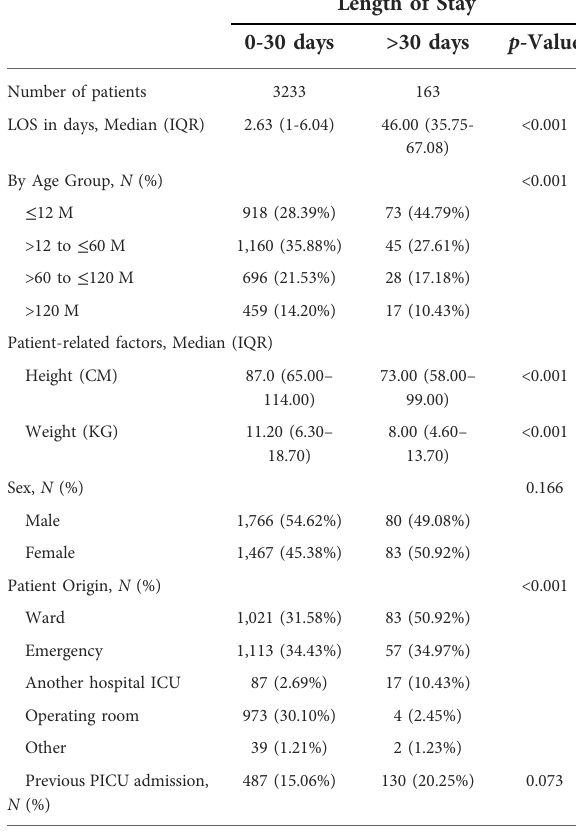
TABLE 1 Patient characteristics in relation to the length of